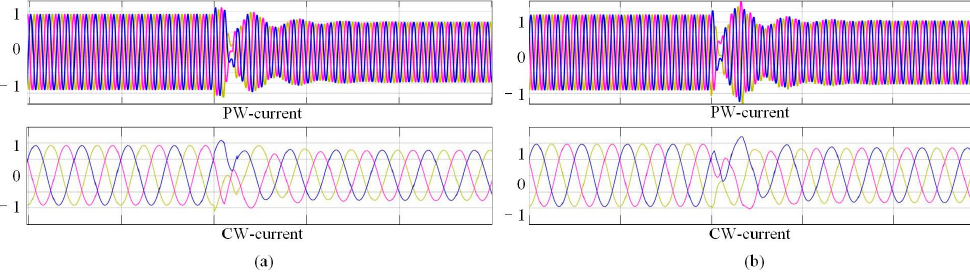
Figure 11. The PW and CW waveforms when the compensation is ( a ) − 0.2 and ( b ) +0.2 deviations.